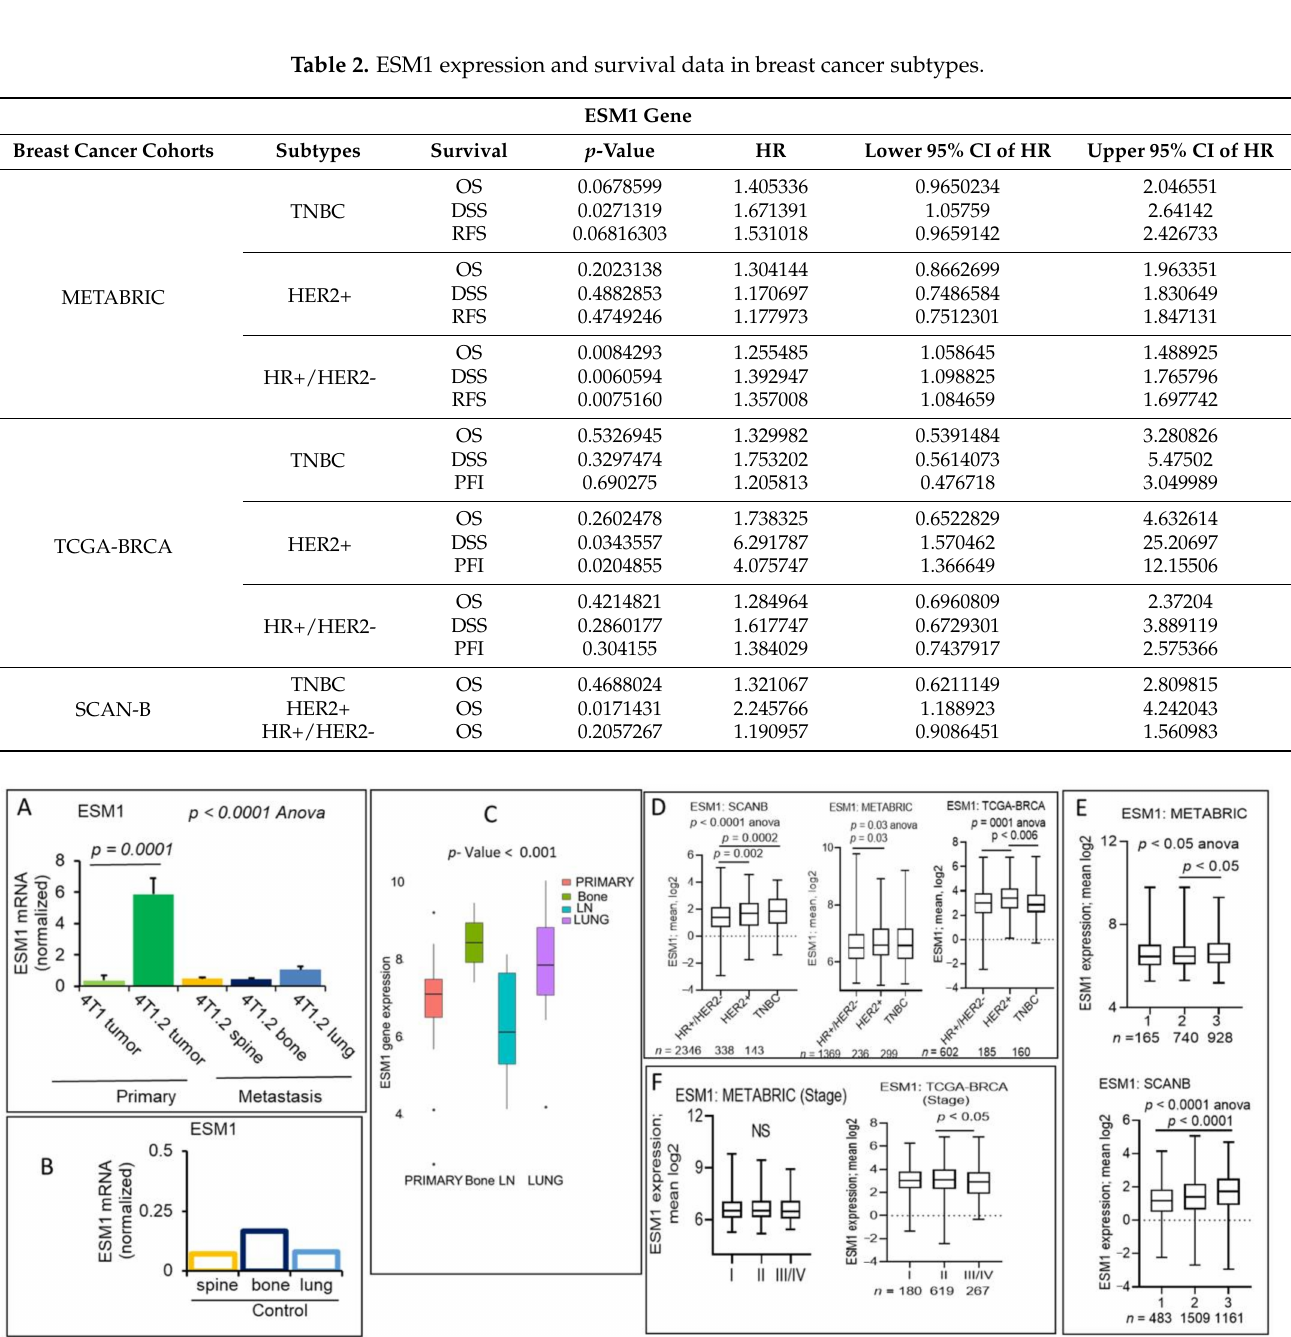
Figure 6. Expression of ESM-1 is downregulated in the 4T1.2 metastatic lesions vs. primary tumors and an independent prognostic factor for aggressive breast cancer subtypes. ( A , B ) ESM-1 gene expression levels were analyzed by qPCR in the primary tumors, metastatic lesions ( A ), and control mice tissues ( B ), as labeled. ESM-1 mRNA levels were normalized with the GAPGH. Data are mean ± SEM, one-way ANOVA p < 0.0001, n = 3. ( C ) Boxplot data showed that ESM-1 mRNA levels were altered in primary tumors vs. metastatic tumors of breast cancer patients, Kruskal–Wallis test (non-parametric method), p < 0.05. ( D ) Boxplots of the ESM-1 high expression score by immunohistochemistry (IHC) determined subtype in the SCAN-B (left), METABRIC (middle), and TCGA-BRCA cohorts (right). Boxplots of high expression of ESM-1 score of tumors of different AJCC stages ( F ) for METABRIC (left panel) and TCGA-BRCA cohorts (right panel) and ( E ) Nottingham pathological grades in METABRIC (upper panel) and SCAN-B cohorts (lower panel). One-way ANOVA and Tukey’s tests were used to calculate p